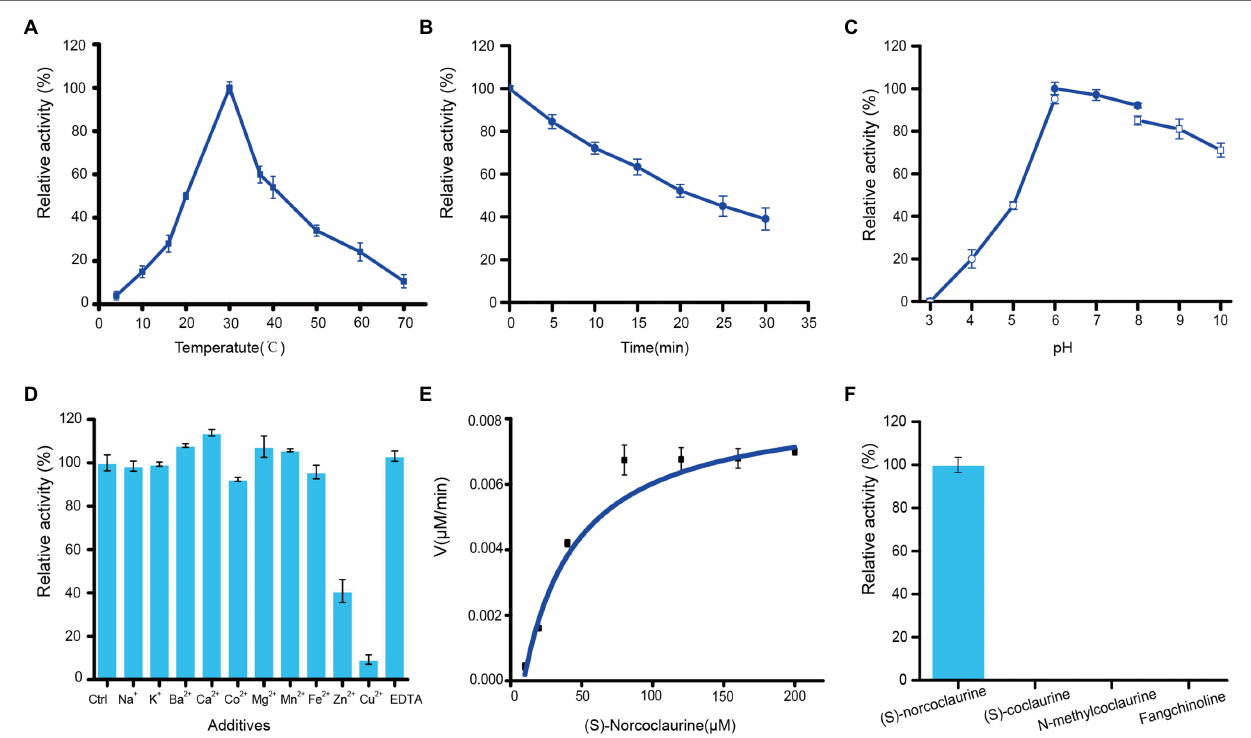
FIGURE 6 | Enzymatic properties of recombinant St6OMT2. (A) Influence of temperature on the St6OMT2 activity. (B) Influence of thermostability of the St6OMT2 at 50 ° C. (C) Influence of pH on the St6OMT2 activity. (D) Influence of EDTA and metal ions on St6OMT2 activity. (E) Enzyme kinetics of St6OMT2 calculated by fitting with the Hill function. (F) Substrate specificity of St6OMT2 toward (S)-norcoclaurine, (S)-coclaurine, N-methyltransferase, and